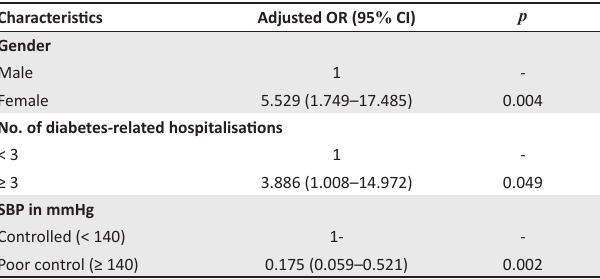
TABLE 6: Multivariate logistic regression showing the association between depression status and socio-demographic and clinical characteristics/ complications.